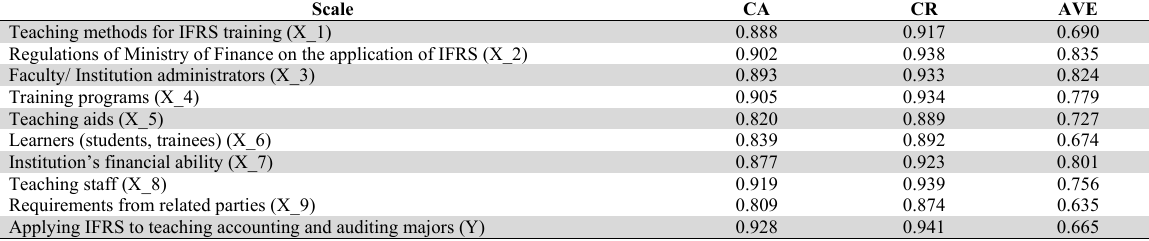
The results of the evaluation of the reliability and convergence value of the scale Scale